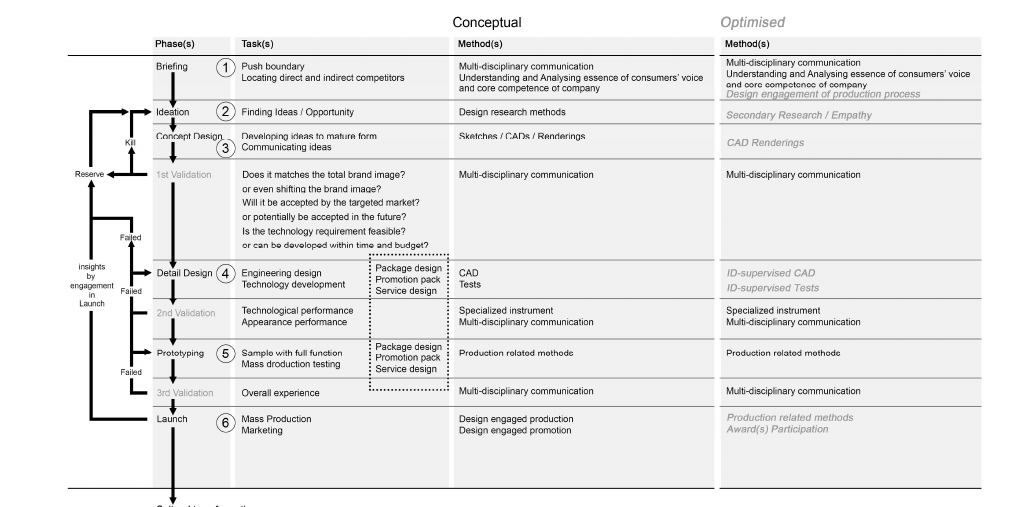
Figure 4 : Modifications of the Conceptual Designer-led NPD Process